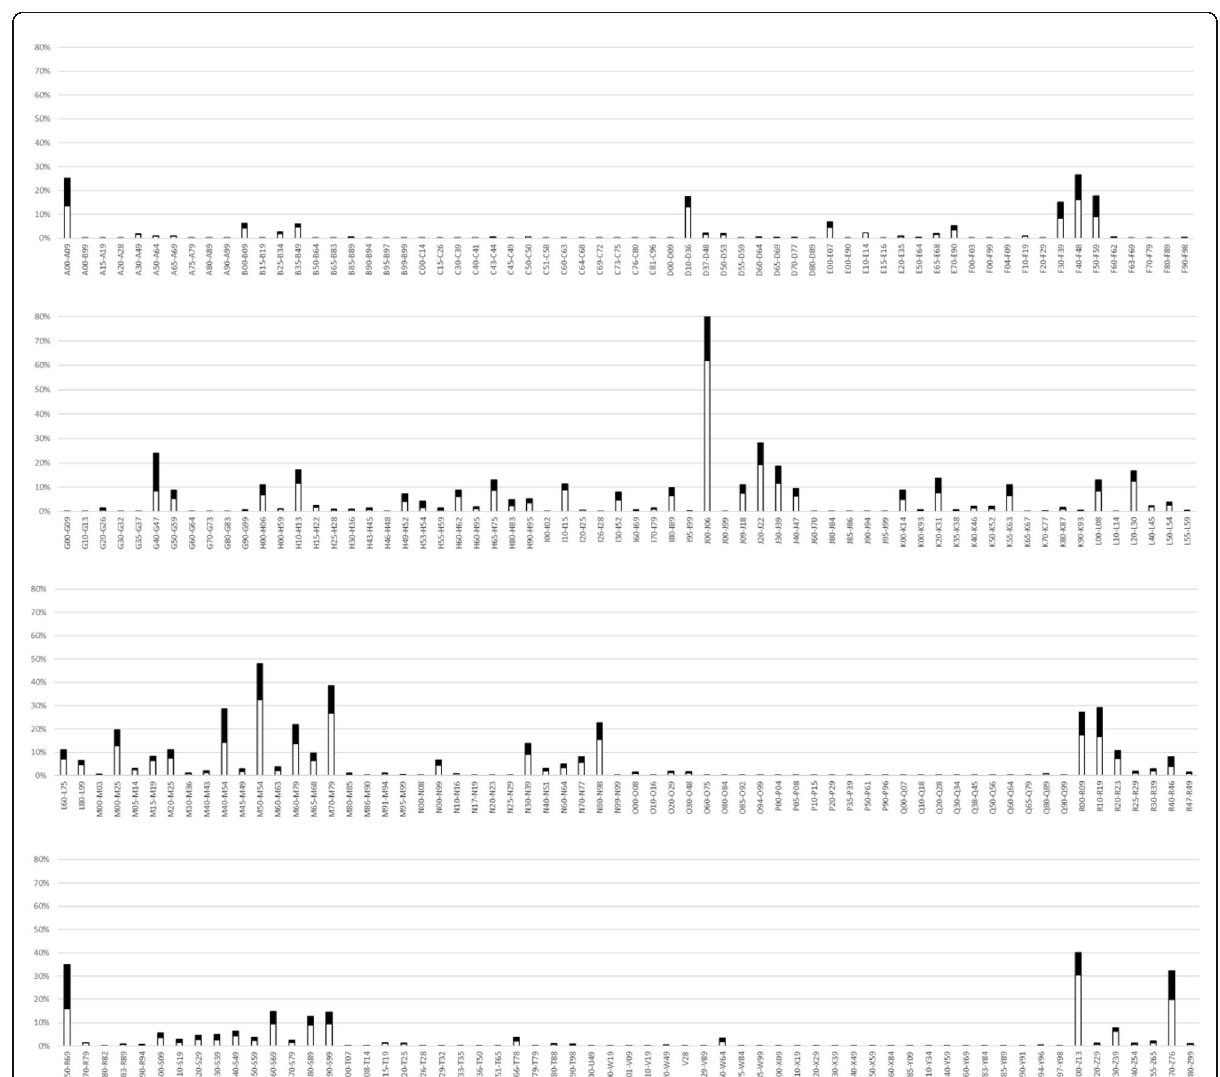
Fig. 7 Prevalence (%) of all ICD-10 blocks in patients with migraine (black) and controls (white). Bars are superimposed on top of each